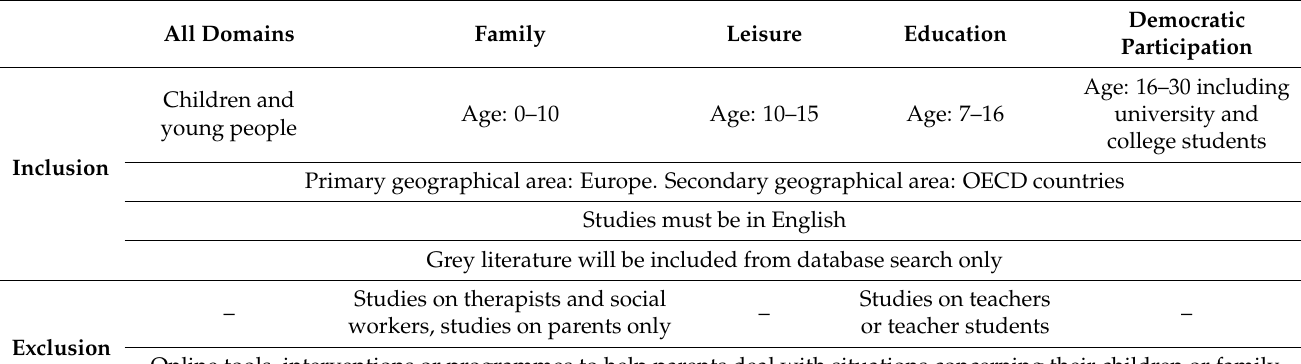
Table 3. Inclusion/exclusion criteria for all domains, screening